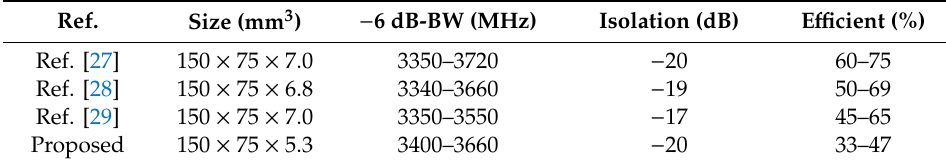
Table 1. Performance comparisons of the multiple-input multiple-output (MIMO) antennas of 5G frame antennas.